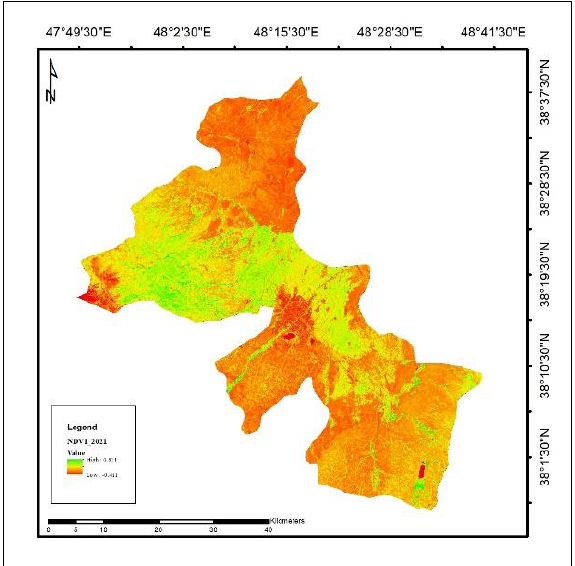
Figure 3. Normalized differential vegetation cover index for the study area for 2021.